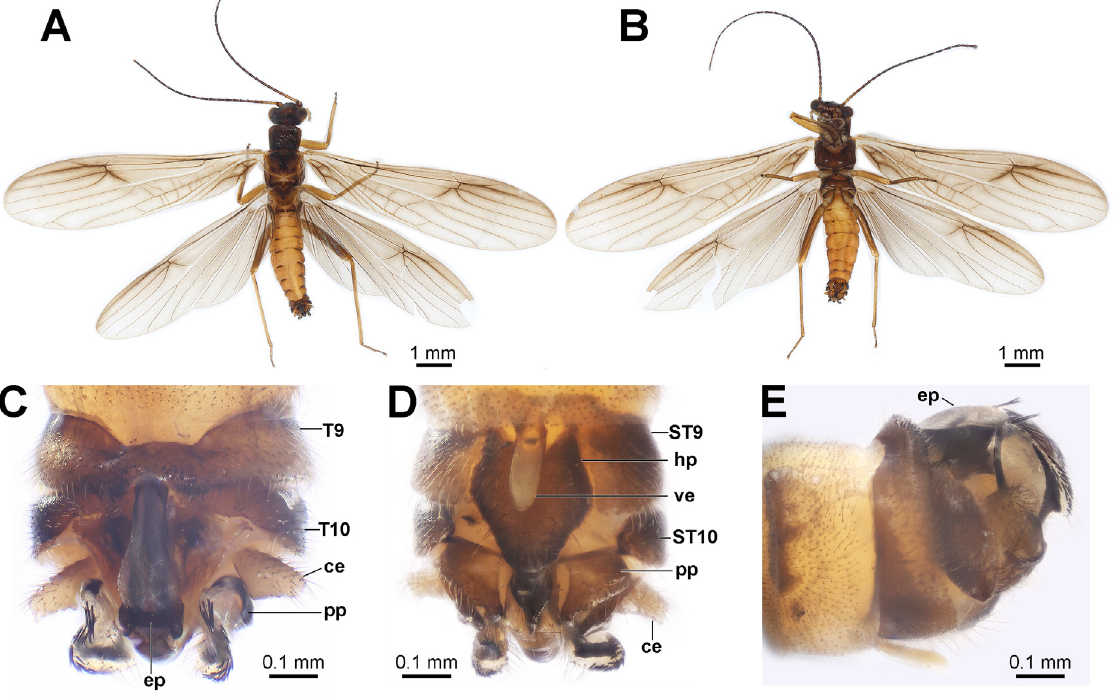
Fig. 8. Amphinemura jiaoheensis sp. nov. A . Male habitus, dorsal view. B . Male habitus, ventral view. C . Male terminalia before NaOH treatment, dorsal view. D . Male terminalia before NaOH treatment, ventral view. E . Male terminalia before NaOH treatment, lateral